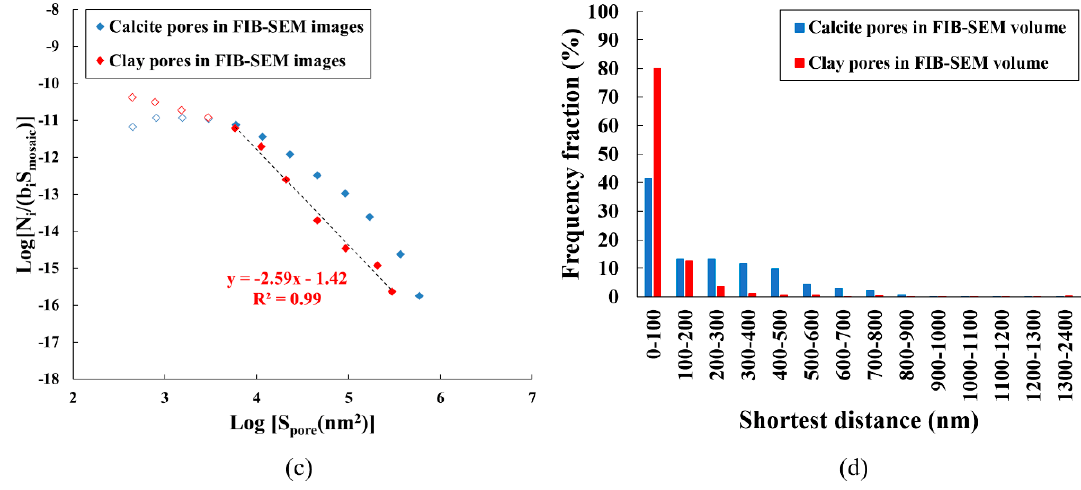
Figure 11. Pore volume fraction distributions ( a ), cumulative porosity distributions (pore volume normalized to respective mineral phase volume) ( b ), and normalized pore size distributions based on 2D FIB-SEM image analyses ( c ). The linear best fit is shown as a dashed line with a corresponding equation. The slope and intercept of the best fit are the minus D and log C values of Equation (2), respectively. The hollow blue and red squares represent the normalized frequencies of pores in calcite and clay when the equivalent circular pore diameter is equal or smaller than 51 nm, respectively. These data points are excluded to obtain linear best fits. The frequency fraction distribution of the shortest distance (edge to edge) between pores and their nearest neighbors in calcite and clay mineral phases of the FIB-SEM volume ( d ).